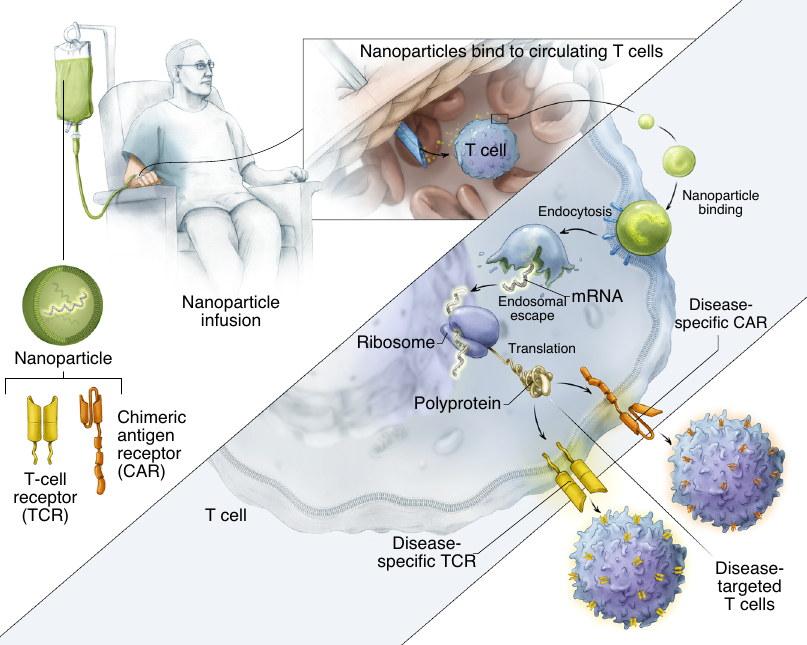
Fig. 1 Schematic illustrating how we reprogram T cells in situ to express disease-speci fi c CARs or TCRs using IVT mRNA carried by polymeric nanoparticles. These particles are coated with ligands that target them to cytotoxic T cells, so once they are infused into the patient ’ s circulation they can transfer the transgenes they carry into the lymphocytes and transiently program the cells to express the disease-speci fi c CARs or TCRs on their